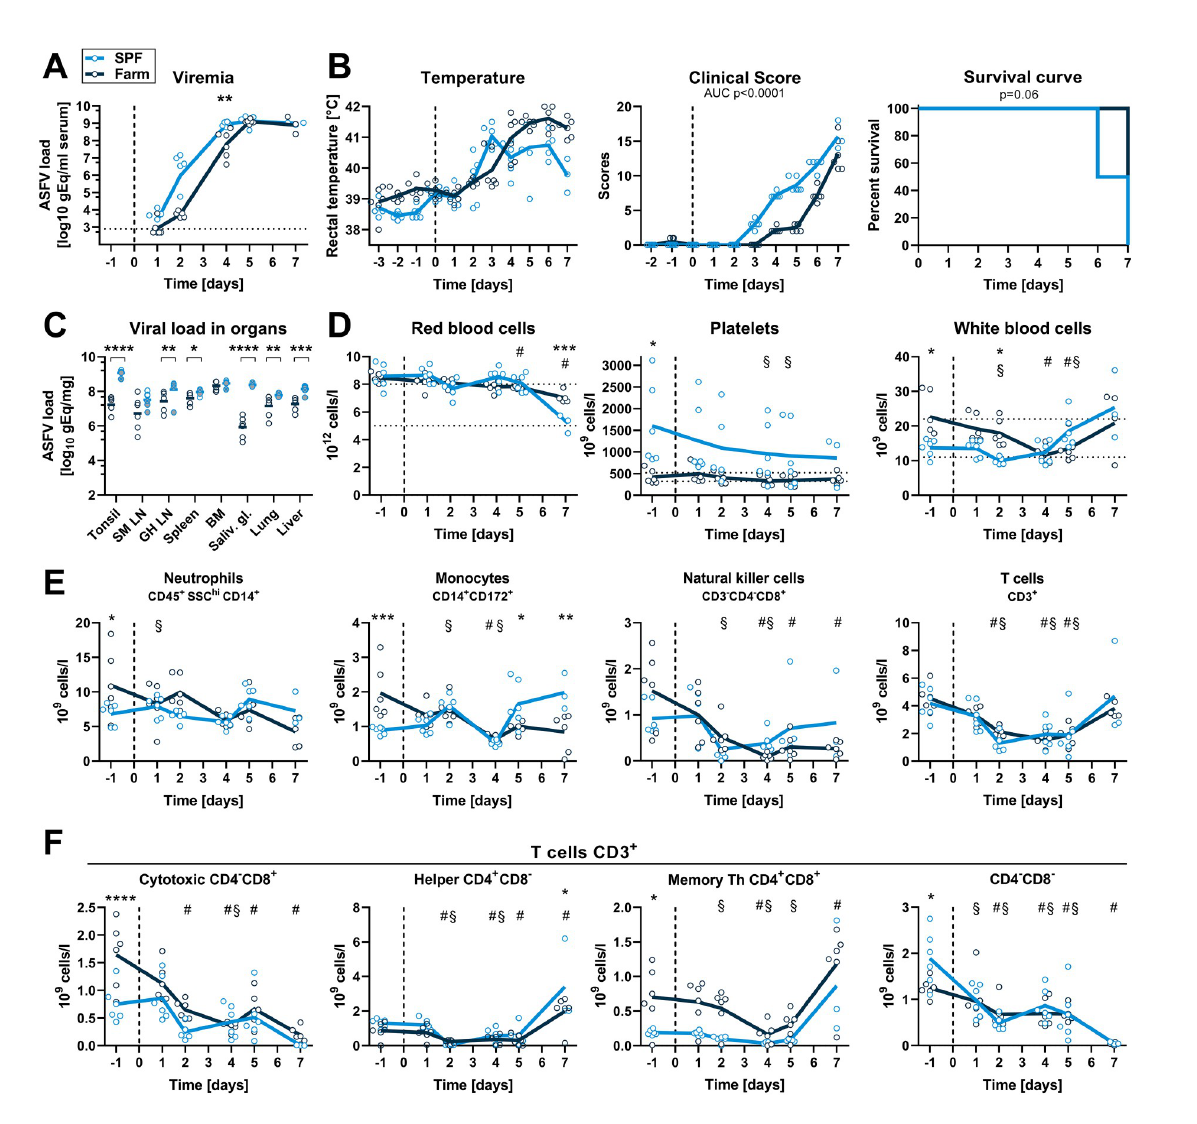
Fig 4. Virus load, clinical signs and blood cell profiles after infection with virulent ASFV strain Armenia 2008. SPF and farm pigs were inoculated intramuscularly with ASFV Armenia 2008. Blood samples were taken 1 day before infection and 1, 2, 4, 5, and 7 dpi. (A) Viremia was determined in serum by qPCR at indicated time points. (B) Rectal temperature, clinical score, and survival were reported daily. (C) Virus load in organs was measured by qPCR on the day of euthanasia (6 dpi: animal found dead, grey circles crossed (SPF n = 1), 6 dpi: grey circles (SPF n = 2), 7 dpi: empty circles (SPF n = 3, farm n = 6)). SM LN, submandibulary lymph node; GH LN, gastrohepatic LN; BM, bone marrow; Saliv. gl., salivary gland. (D) RBC, PLT, and WBC counts in blood at indicated dpi. (E) Immunophenotyping of blood leukocytes (CD45 + ). Percentage of each subset was determined by flow cytometry gating (S2 Fig) and absolute numbers were calculated using WBC counts. (F) T cell subsets were gated from CD3 + T cells. (A-F) Each data point represents the value for one pig, lines indicate the mean of each group. Data are from a single experiment (n = 6 pigs/group, except 7 dpi, where n = 3 for SPF group). (A, C-F) Differences between SPF and farm groups were analyzed by unpaired t test at each dpi with Holm-Sidak’s correction for multiple comparisons. � p < 0.05; �� p < 0.01; ��� p < 0.001; ���� p < 0.0001. (B) Differences between groups for body temperature and clinical scores were analyzed by comparing the area under the curve (AUC). Differences in survival were analyzed by Log-rank (Mantel-Cox) analysis. (D-F) Significant differences at different dpi compared to the respective baseline (-1 dpi) are indicated for SPF (§, p < 0.05) and farm (#, p < 0.05); data were analyzed using mixed model analysis followed by Dunnett’s multiple